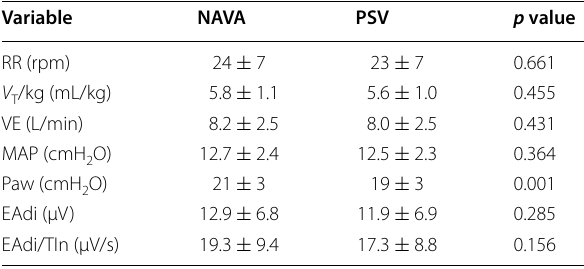
Table 3 Respiratory variables during the study protocol